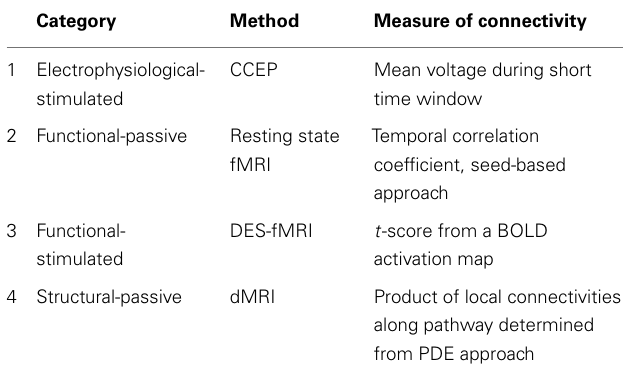
Table 2 | Summary of the four measures of connectivity used for comparisons in epilepsy patients who underwent evaluation with intracranial electrodes .